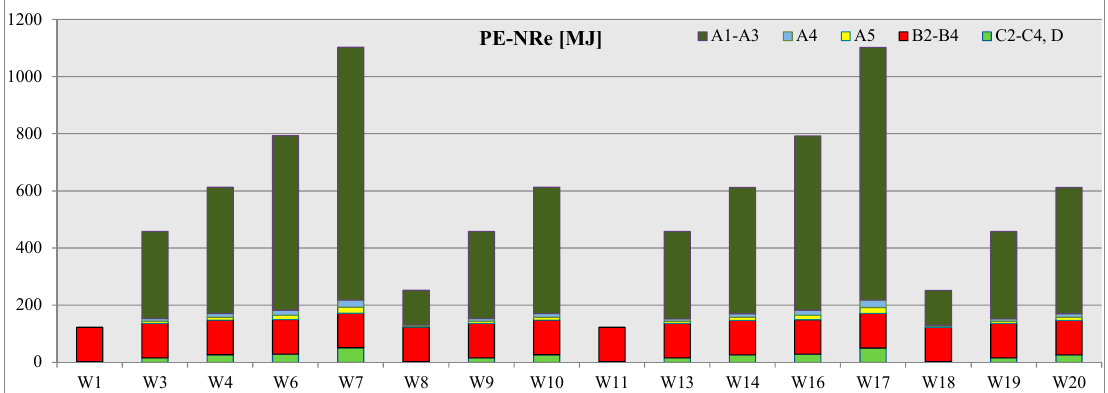
Figure 4. C2C consumption of nonrenewable primary energy (PE-NRe, in MJ, with the energy needed for heating and cooling not being considered) of each alternative of external wall.